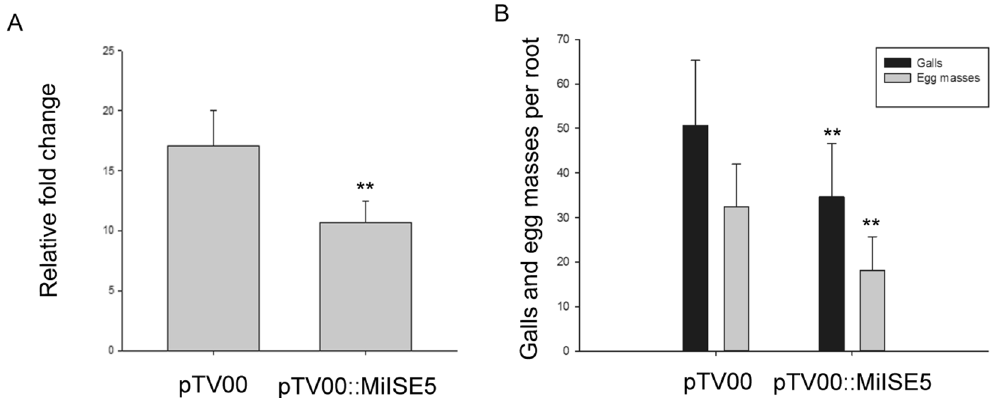
Figure 5. TRV-mediated MiISE5 silencing effect on nematode parasitism. ( A ) q-PCR assays were used to determine the specificity of RNAi. Each bar represents the mean ± SD of three biological replicates. ( B ) The average number of galls and egg masses per root. Each bar represents the mean ± SD of three biological replicates, and the mean values significantly different from the control are demoted by ** as determined by independent samples t -test (P <